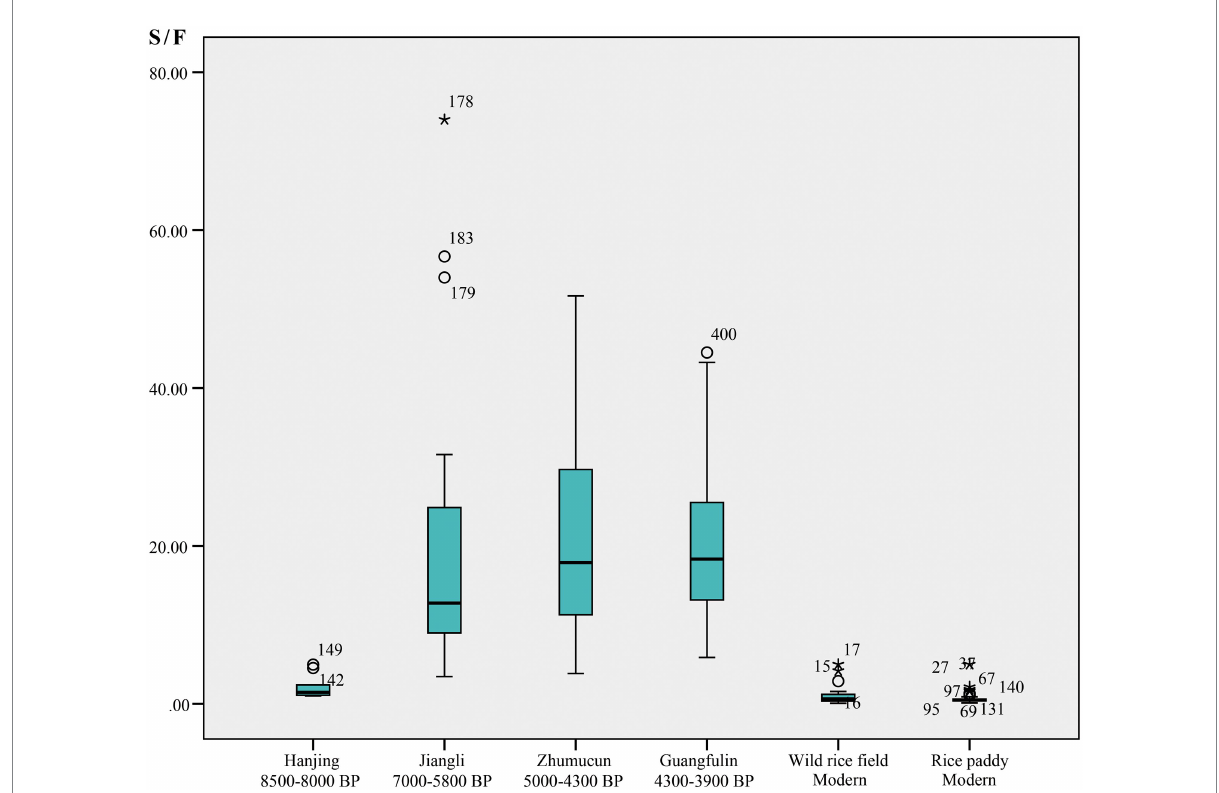
FIGURE 4 Comparison of phytolith assemblages in paddy fields. The numbers in the figure area indicate the number of anomalous data beyond the edge of the boxplot, where the circles are closer to the edge and the asterisks are further away. The original phytolith data of Hanjing, Jiangli, Zhumucun, Guangfulin, modern wild fields and modern paddy fields was cited from Qiu et al. (2014a,b,c, 2018b, 2022), Zheng (2014), Huan et al. (2018), and Qiu